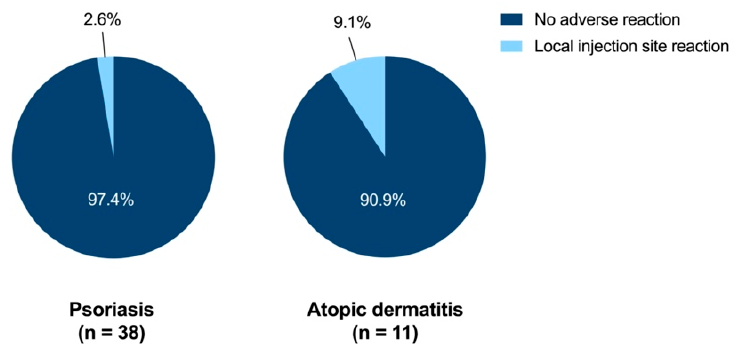
Figure 6. Tolerability of pneumococcal vaccination. Analysis is based on the patients who had been vaccinated according to the questionnaire (n = 38 for PsO and n = 11 for AD). The pie charts display the tolerability of pneumococcal vaccination in psoriasis and atopic dermatitis patients. There were no systemic reactions such as fever, fatigue or exhaustion or other serious health disorders.